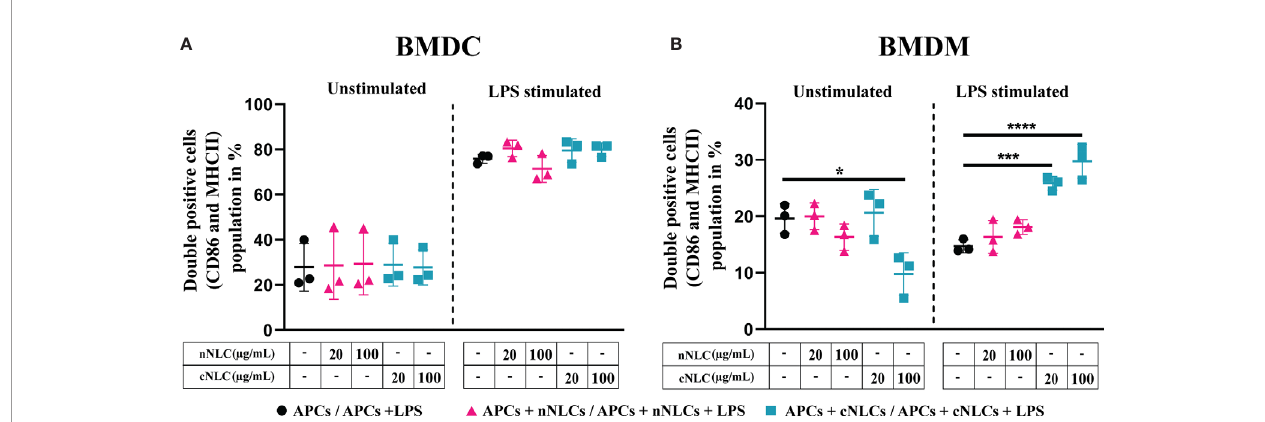
FIGURE 3 | Expression of activation surface marker in APCs following exposure to nNLCs or cNLCs. BMDCs (A) and BMDMs (B) were exposed to nNLCs or cNLCs for 24 h, followed by LPS stimulation for an additional 24 h. Percentage of double-positive (CD86 and MHC-II) BMDCs and CD86 positive BMDMs were determined, with gating on CD11b and Cd11c positive cells for BMDCs and CD11b and F4/80 positive cells for BMDMs. Data are displayed as mean ± SD (N = 3 independent experiments), and the statistical signi fi cance between nanocarrier treated or untreated groups was performed by one-way ANOVA test using Tukey ’ s multiple comparisons test. *P ≤ 0.05; ***P ≤ 0.001; and ****P ≤